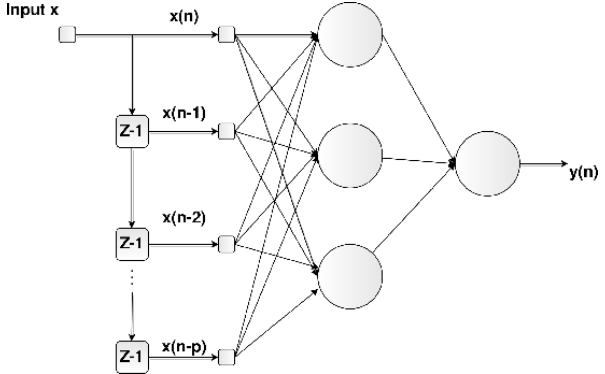
Figure 11. Time-delay neural network